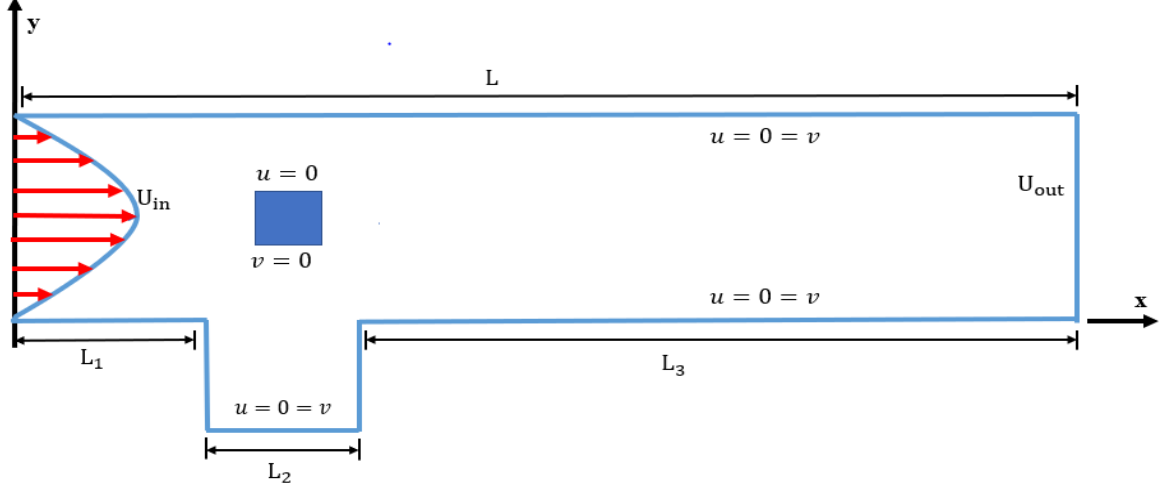
Figure 1. Physical configuration of the problem.